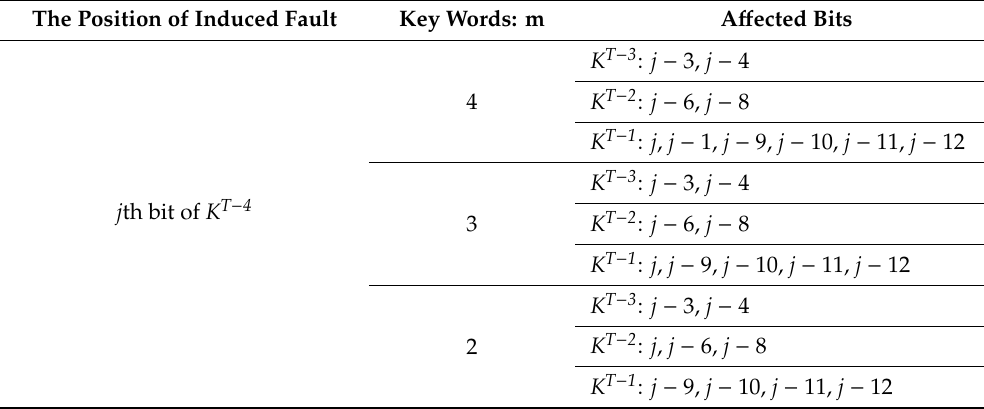
Table 2. The j th bit of K T − 4 a ff ects the bits of K T − 3 , K T − 2 and K T − 1